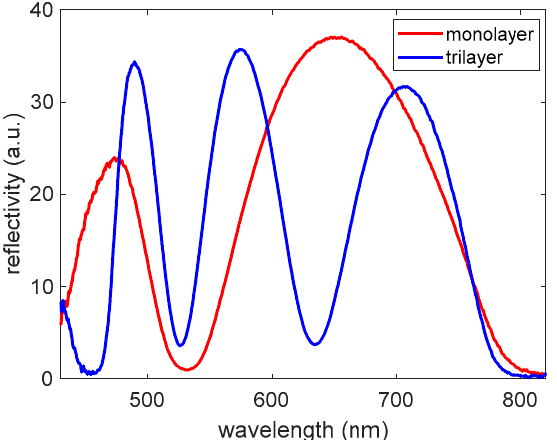
Figure 3. Comparison of the optical reflectance spectra in air for the mesoporous TiO 2 monolayer (thickness = 210 nm) and tri-layer (thickness = 651 nm).